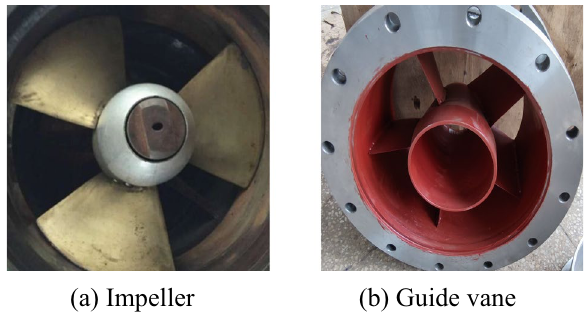
Figure 1. Hydraulic model of the axial flow pump.